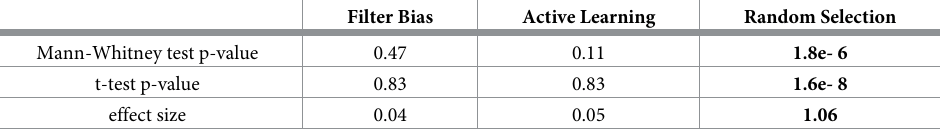
Table 13. Results of the Mann-Whitney U test and the t-test comparing the inequality for the three forms of iter- ated algorithmic bias with class-dependent human action probability ratio 1:1 and 10:1. The effect size is calculated as ( Boundary | ratio = 1: 1 − Boundary | ratio = 10: 1 )/ standard . dev at time t = 200. Both Filter bias and active learning bias show no significant difference between the two ratios. On the other hand, random selection has decreased the class-1 blind spot